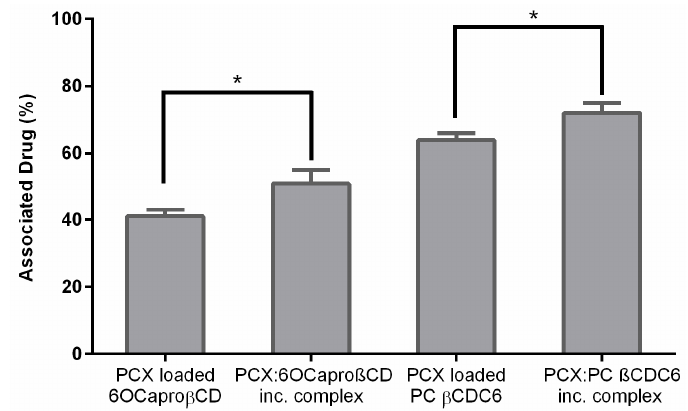
Figure 5. Associated drug (%) of PCX loaded nanoparticles ( n = 3, ±SD), * p < 0.05.